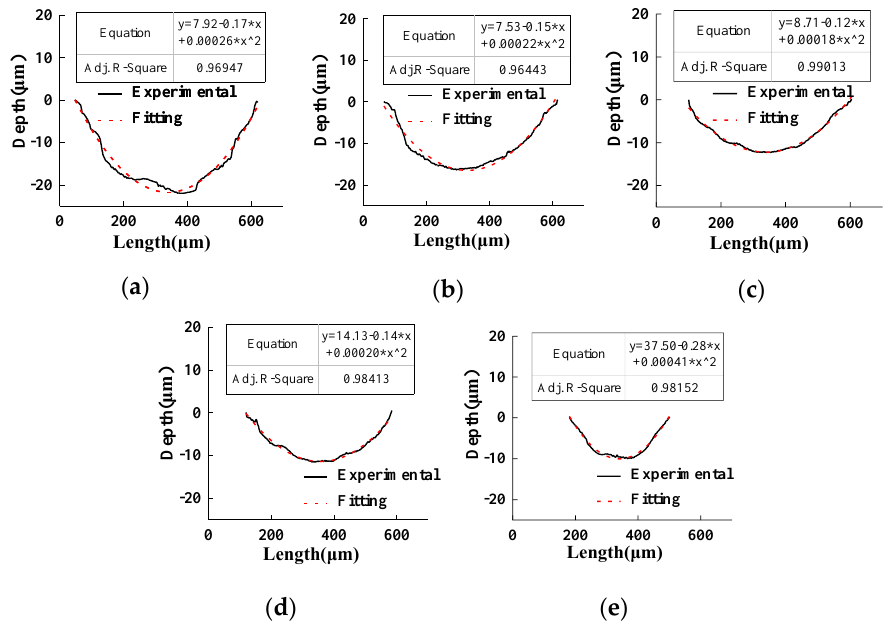
Figure 4. Fitting of wear depth profiles of cyclic loaded wires in cases of distinct environmental media.